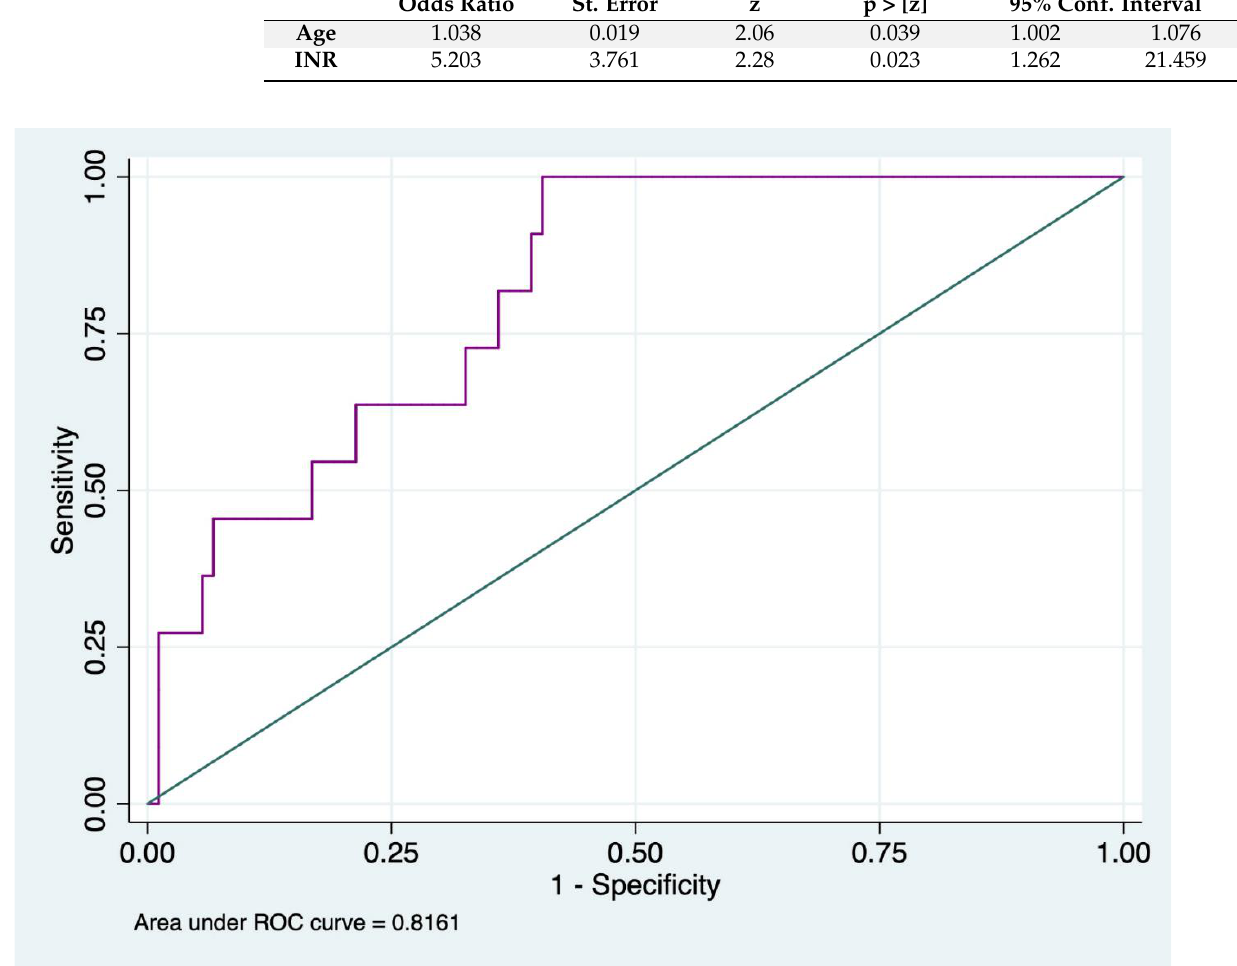
Table 3. Logistic regression analysis of clotting factors to predict in-hospital mortality. Odds Ratio St. Error z p > [z] 95% Conf. Interval